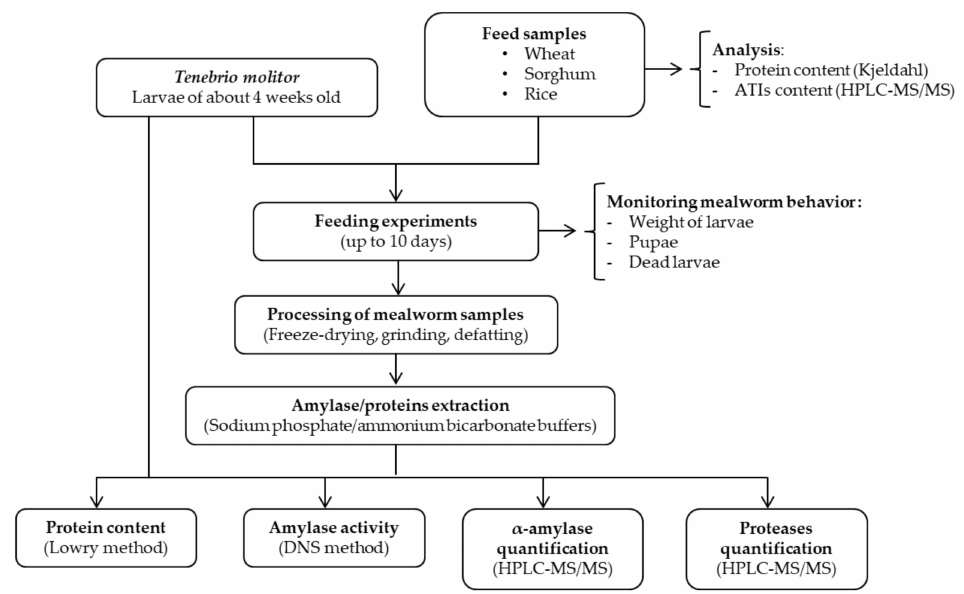
Figure 1. Workflow presenting the different experimental steps implemented in this study, as well as the analysis